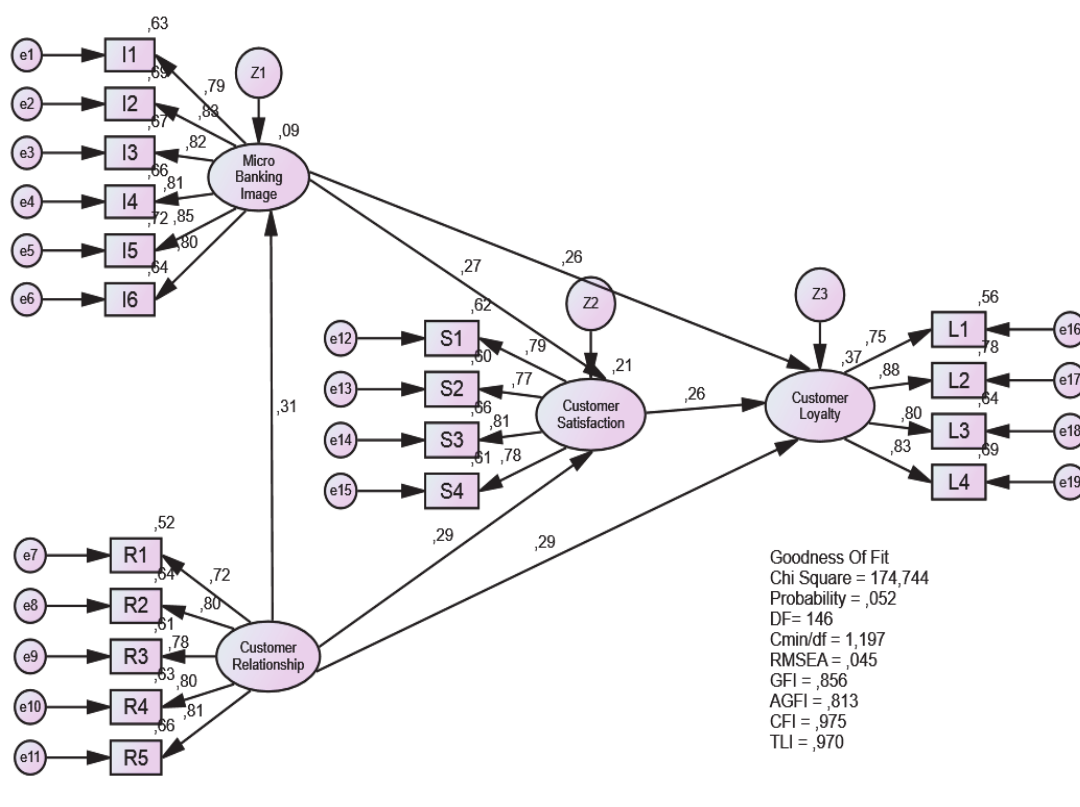
Fig. 1. Result of Path Analysis